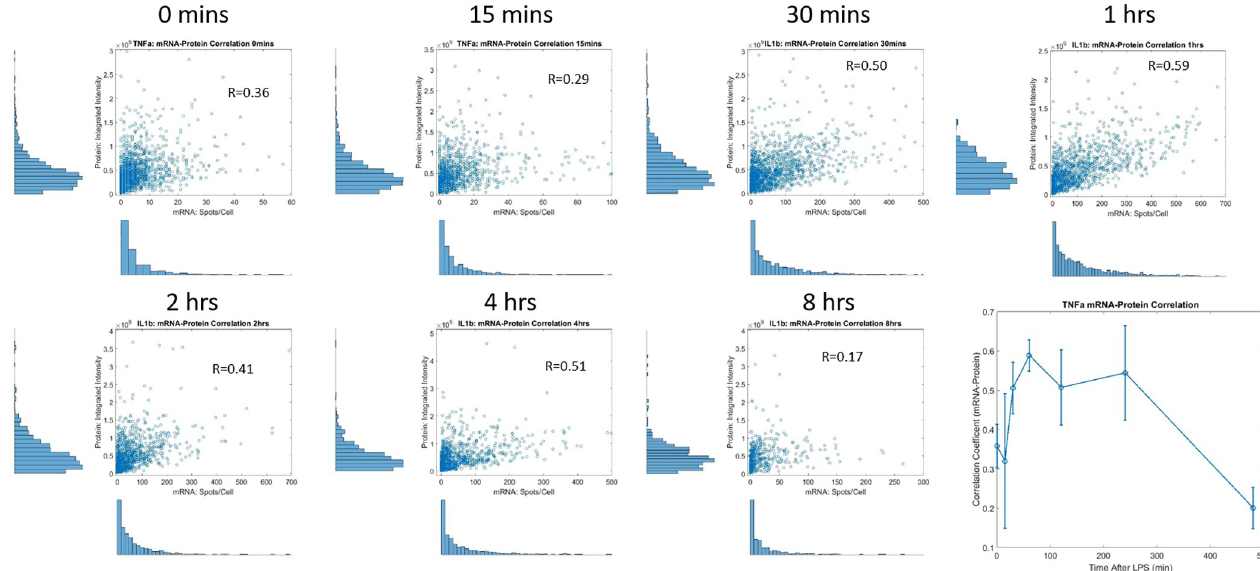
Fig 9. Scatter plots of TNF- α mRNA-Protein data and correlation plot over time.